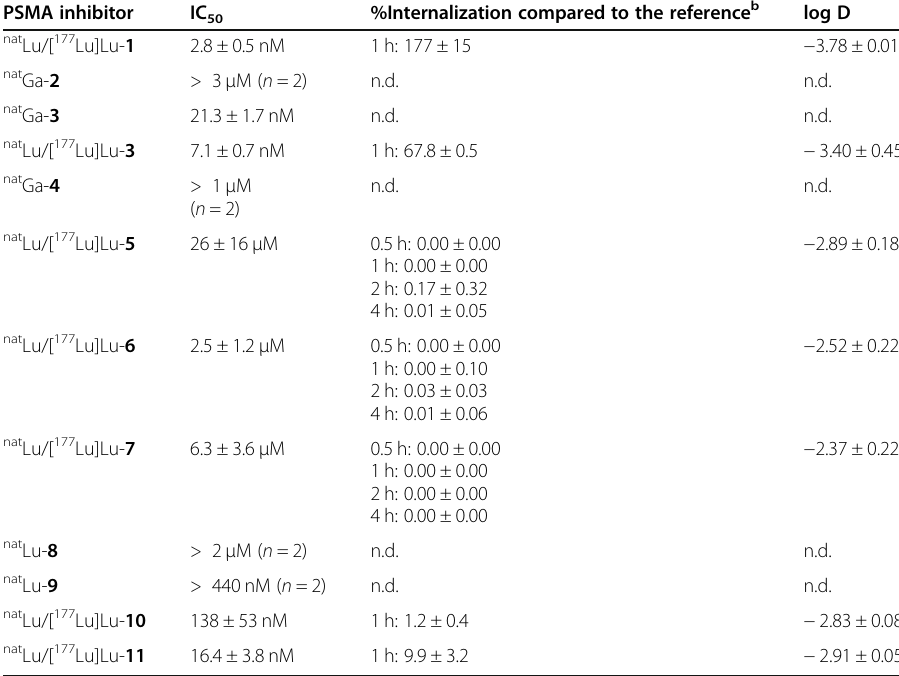
Table 1 PSMA-binding affinities (IC 50 ), internalization (%) and lipophilicity (log D) of the investigated compounds a PSMA